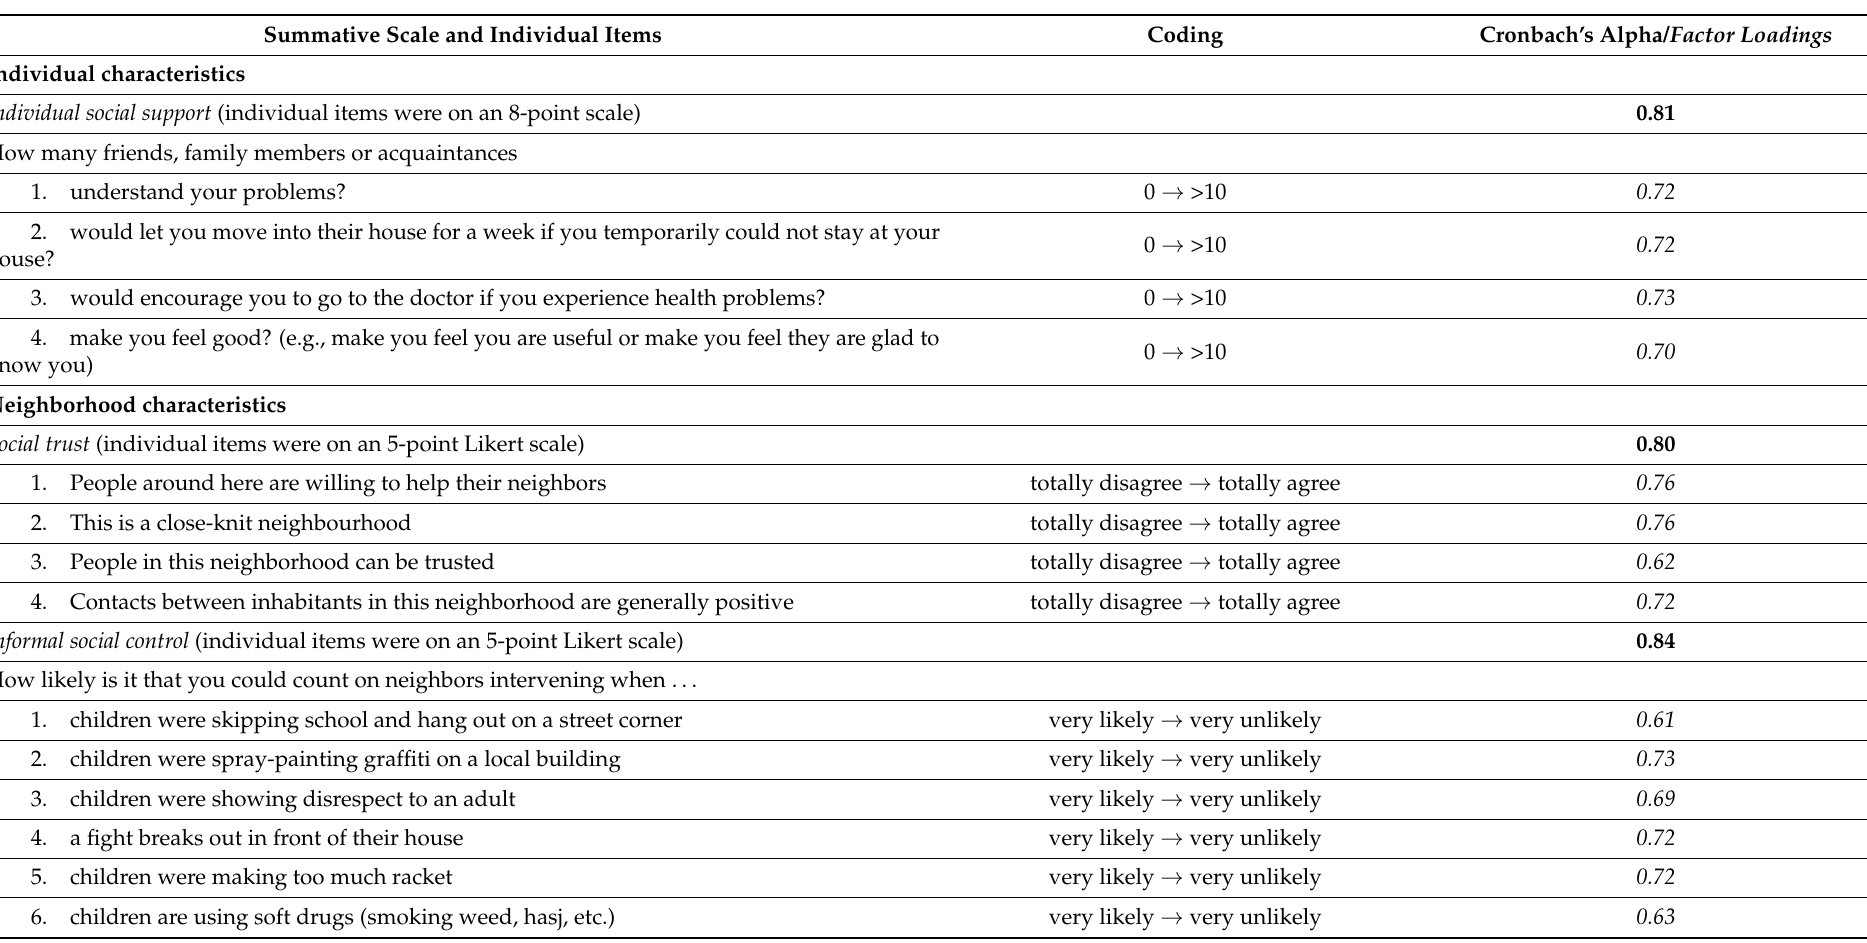
Table A1. Results of factor and reliability analyses regarding scale construction for relevant indicators (Cronbach’s alpha’s in bold, factor loadings in